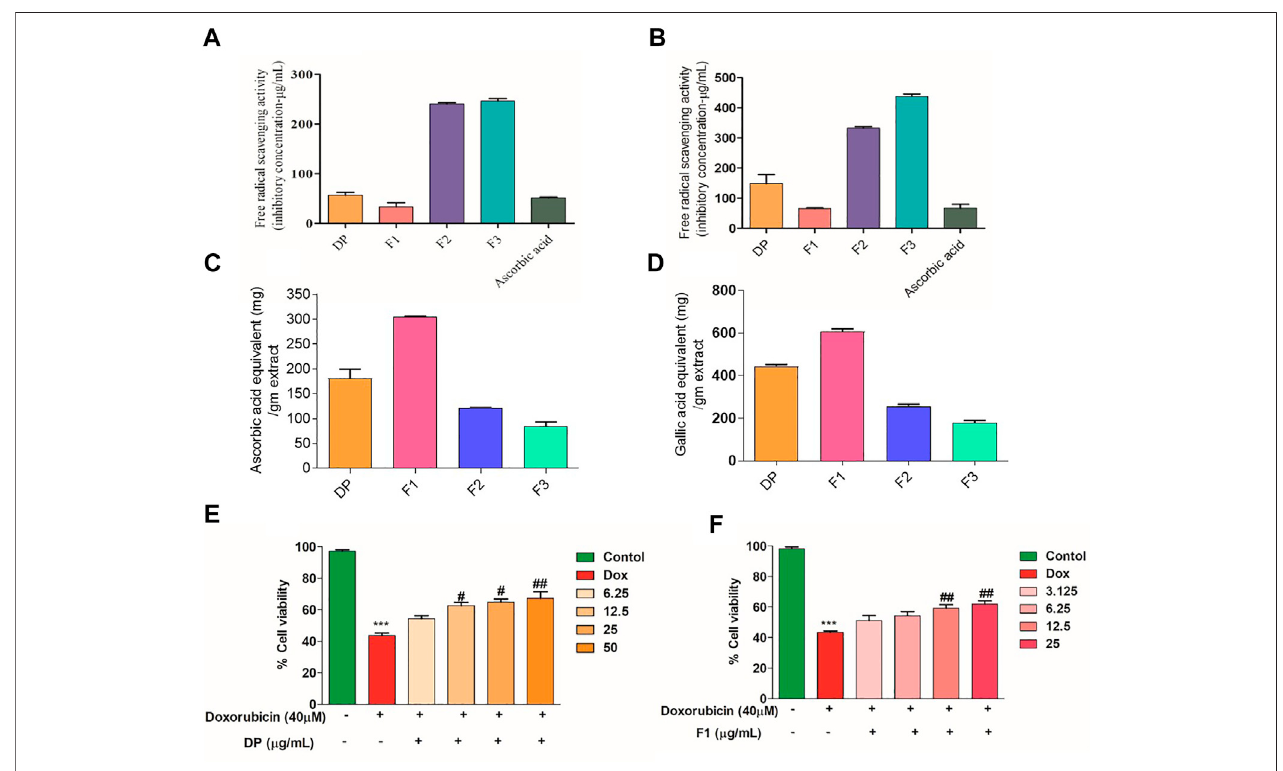
FIGURE 2 | IC 50 values of the bioactive fractions in various antioxidant assays. (A) ABTS and (B) DPPH assay compared with ascorbic acid. (C) FRAP assay (equivalent ascorbic acid/gm extract) (D) Total phenolic content (Gallic acid equivalent/gm extract). (E, F) Cell viability of cardiomyocytes (H9c2) pre-treatment with DP and Fraction F1 along withDox. Values were expressed asMean ± SEM ( n (cid:2) 3). The datawereanalyzed byOne Way ANOVA using Graph Pad Prism. *** p < 0.001, and ** p < 0.01represents Control vs Dox control. ## p < 0.01 and ### p < 0.001 represents Dox control vs Treatment groups.